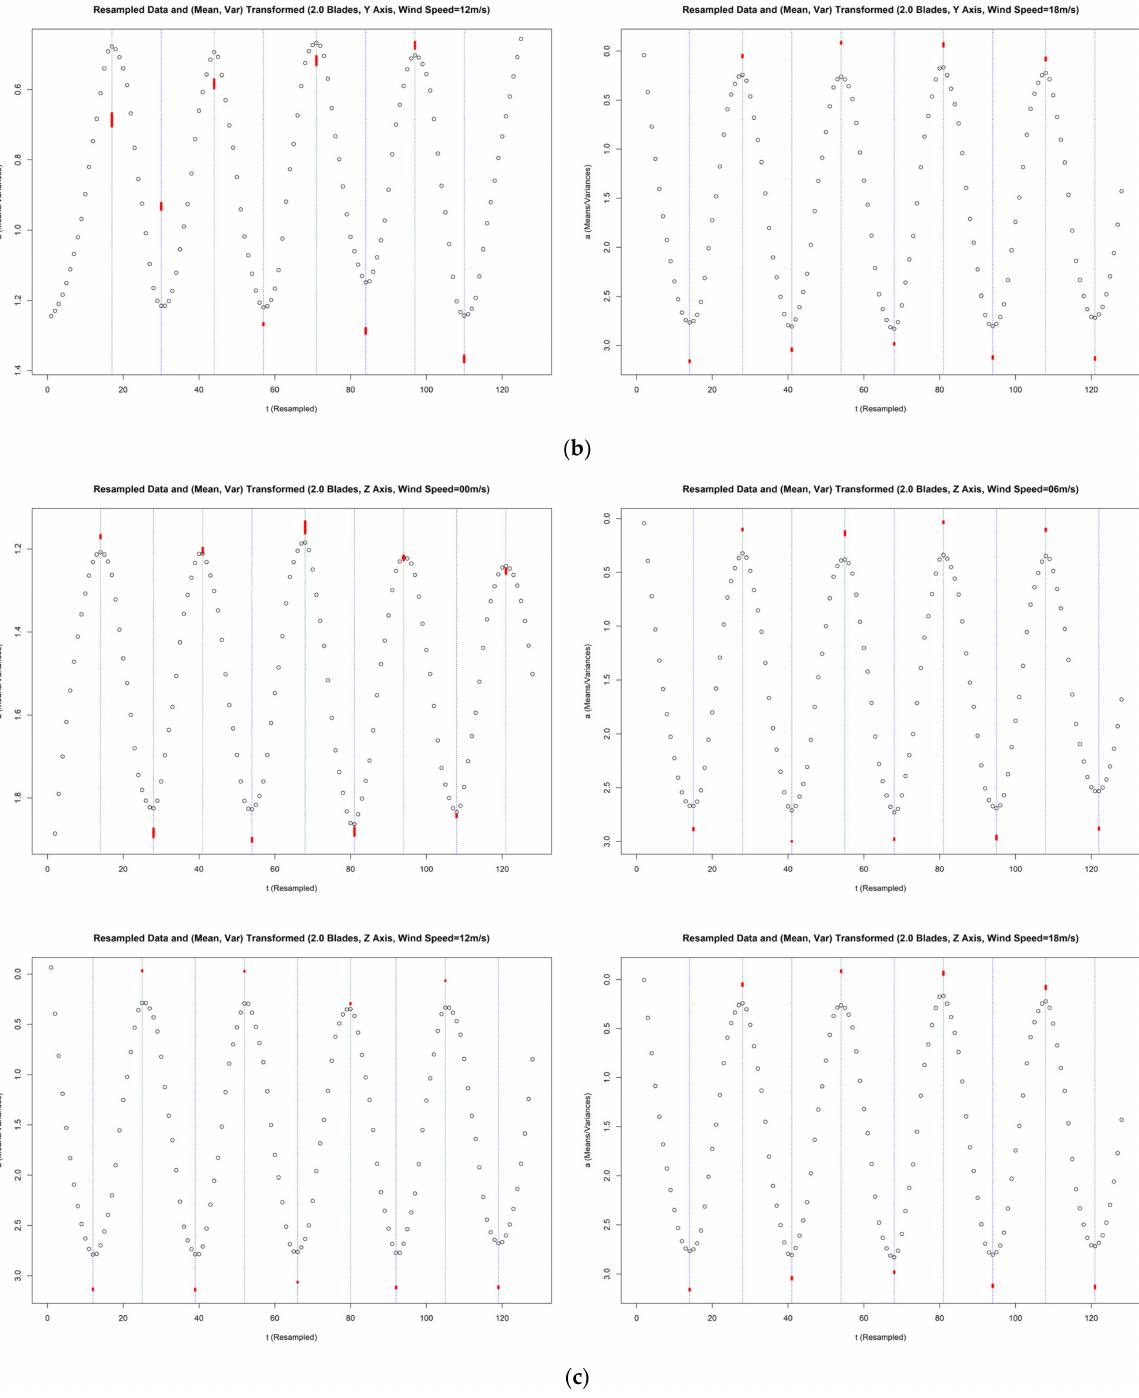
Figure A9. Means and peak/valley variances of resampled data for the 2.0-blade turbine. ( a ) Based on datasets recorded along the X axis with different wind-speeds imposed. ( b ) Based on datasets recorded along the Y axis with different wind-speeds imposed. ( c ) Based on datasets recorded along the Z axis with different wind-speeds